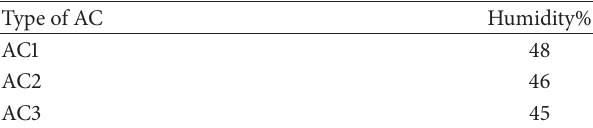
Table 3: The percentage of moisture content for AC samples. Type of AC